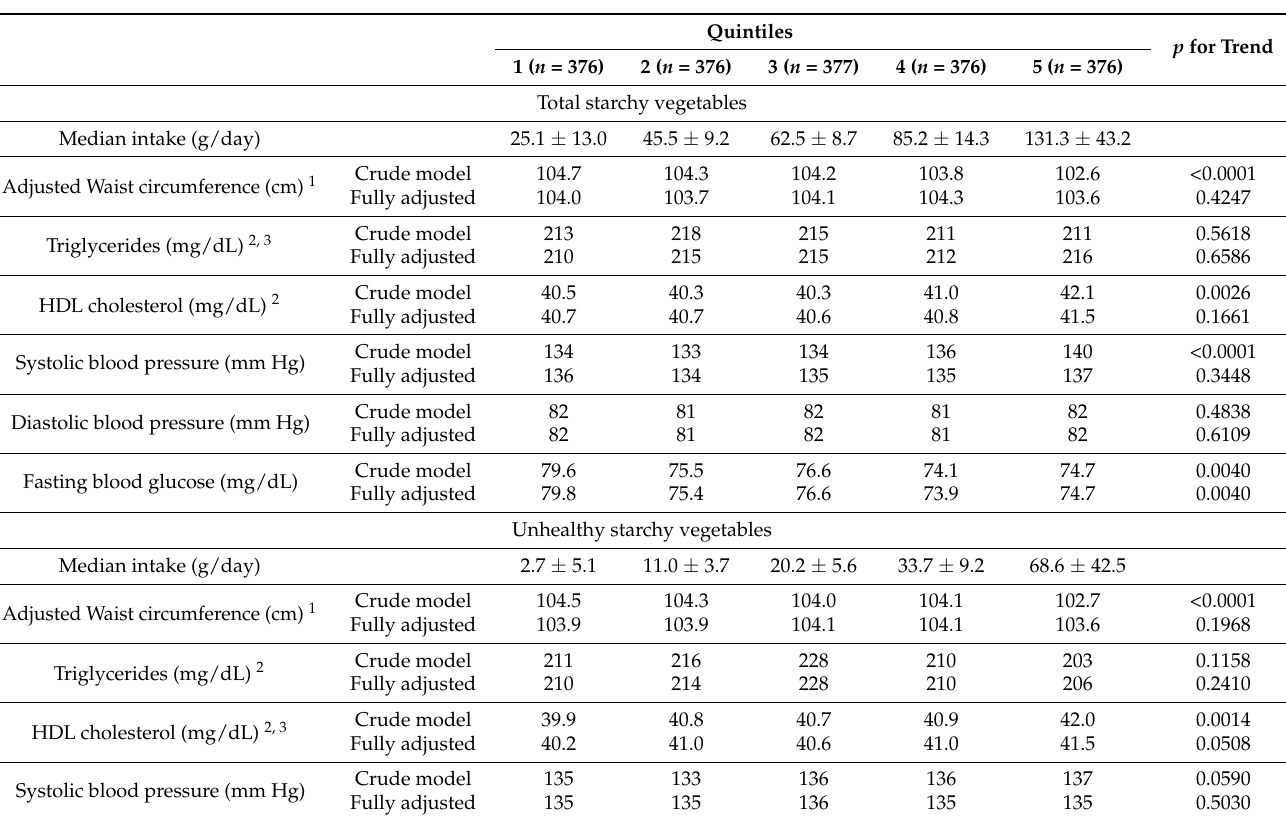
Table 3. Least square means of metabolic syndrome components according to quintiles of total starchy vegetables, un- healthy starchy vegetables, and healthy vegetables consumptions in crude and fully adjusted models ( n =